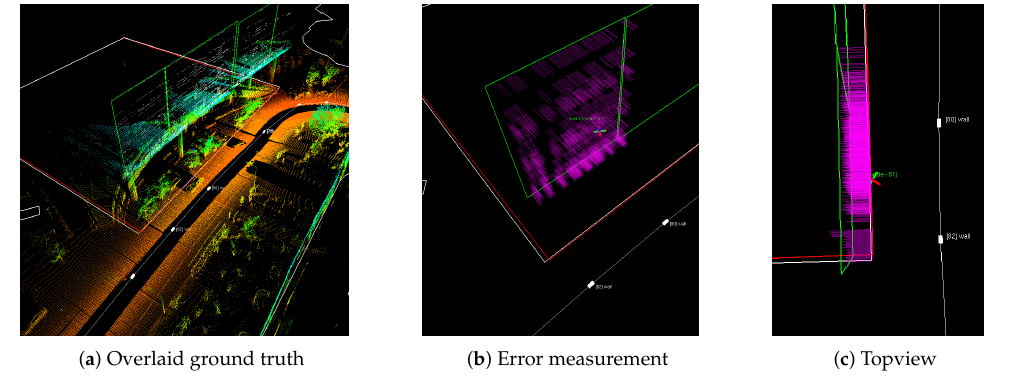
Figure 18. ( a ) Red square drawn from four sample ground truth corners. ( b ) By measuring perpendicular distance (purple line) from 3D point cloud to ground truth (red line) error is measured. ( c ) shows the topview for a clear illustration. Table 5. Positional error measurement between the 3D building point cloud and RTK-GPS measured building corners. The map error is computed from average of RMSE between the ground truth wall generated from RTK measured sample points and LiDAR 3D points in the mapped wall. Note that this error is over 9.32 km of travel distance.